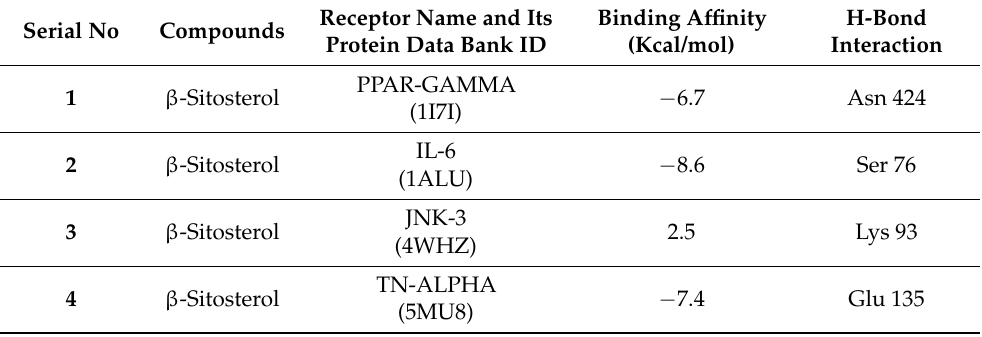
Figure 13. Effect of SIT on histopathology of adipose tissue: ( A ) normal rats; ( B ) type-2 diabetic rats showed an expansion of adipocytes with increased fat accumulation when compared with control; ( C ) type-2 diabetic rat treated with SIT (20 mg/kg b.wt/day orally for 30 days) showed a restored architecture of adipose tissue when compared with type-2 diabetic rats and ( D ) type-2 diabetic rats treated with metformin (50 mg/kg, b.wt/day orally for 30 days) showed also that it restored the architecture of adipocytes close to normal control rats. Table 2. Best possible binding affinities of the β -sitosterol at four targeted proteins’ active sites and their corresponding energy